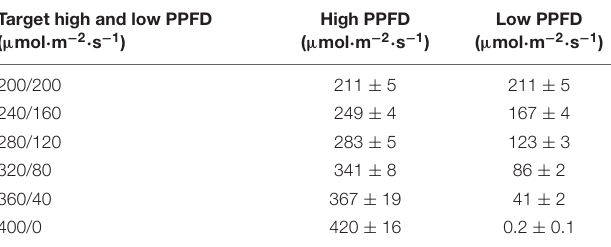
TABLE 1 | Target PPFDs (mean ± SD ; n = 3) and actual measured PPFDs for each fluctuating lighting